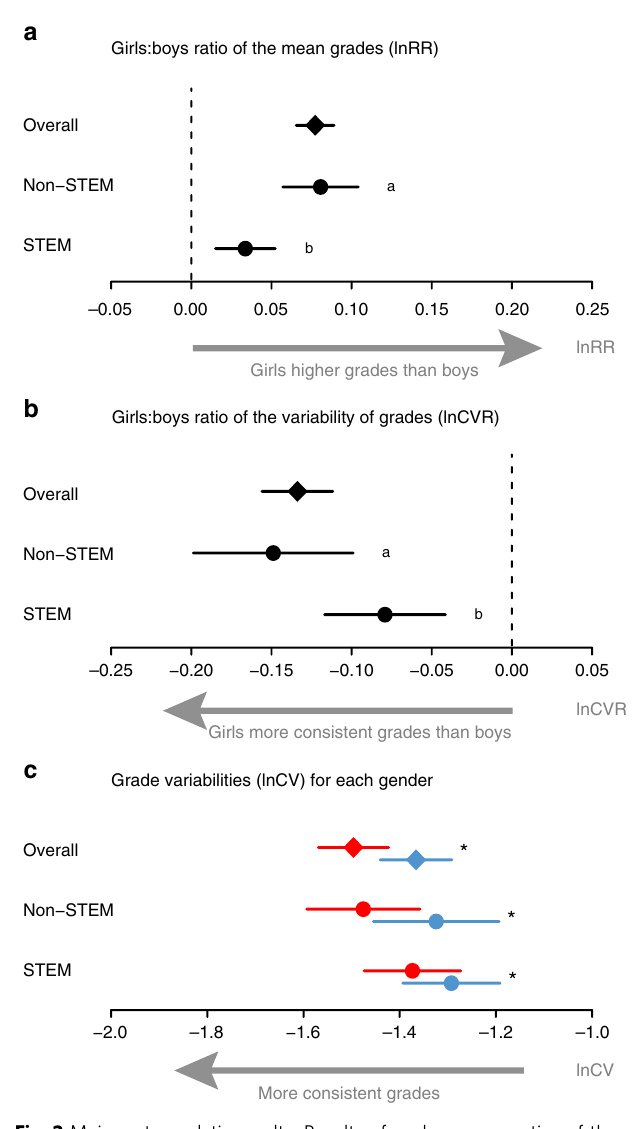
Fig. 2 Main meta-analytic results. Results of analyses on a ratios of the grade means, b ratios of grade variabilities, and c coef fi cients of variations for girls (red) and boys (blue). Diamonds and circles represent meta- analytic estimates of mean effect sizes, and their 95% con fi dence intervals are drawn as whiskers. In a , natural logarithm of response ratio (lnRR) represents the average difference between girls ’ and boys ’ mean grades; positive values of lnRR indicate lower boys ’ mean grades. In b , natural logarithm coef fi cient of variation ratio (lnCVR) represents the average difference in grade variation between boys and girls; negative values of lnCVR indicate greater male variance. In c , natural logarithms of the coef fi cient of variation (lnCVs) are shown for boys and girls to illustrate grade variation by gender; more negative values of lnCV indicate less variation. Data and code for reproducing this fi gure are available